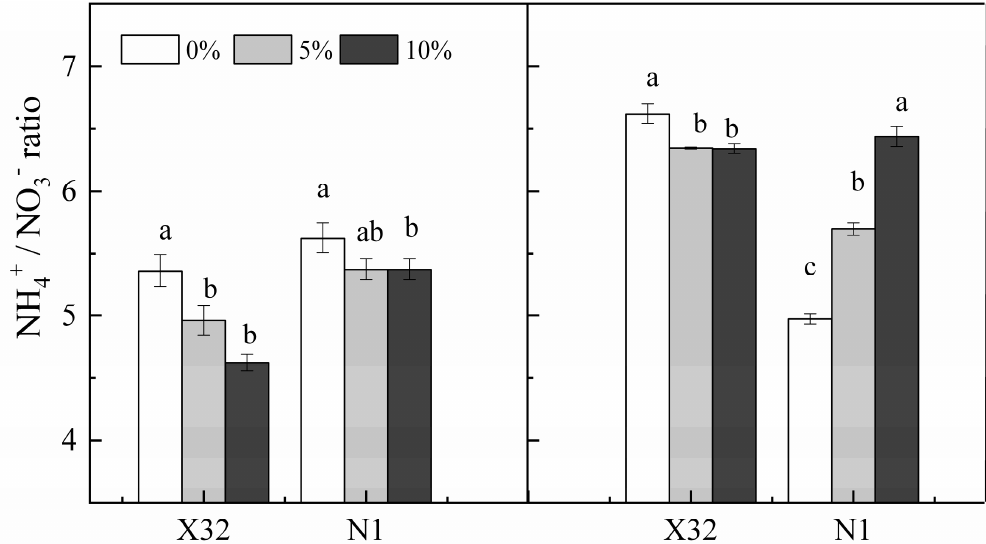
Figure 7. Effects of drought stress on the NH 4+ /NO 3 ‐ ratio in leaves and roots of the sweet potato. X32 and N1 represent Xushu 32 and Ningzishu 1, respectively. Different letters in the same cultivar indicate significant differences ( p < 0.05) among the three PEG levels in the figure.